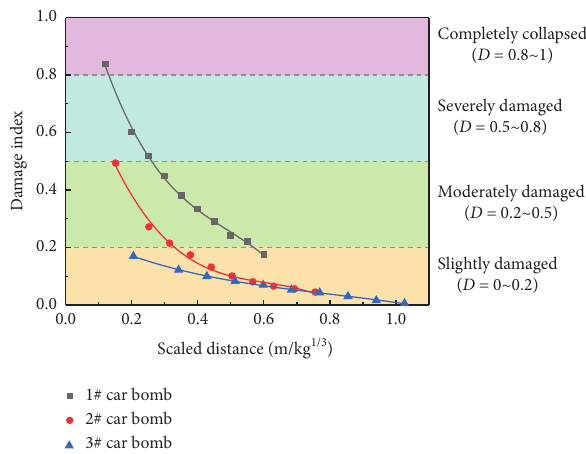
Figure 10: Damage index-scaled distance